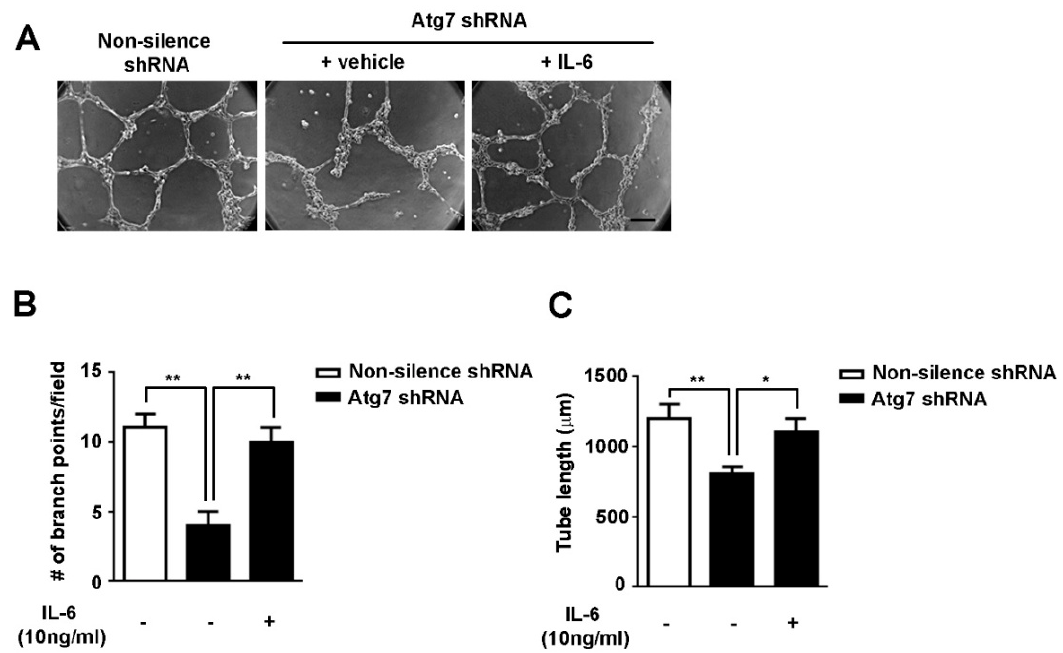
Figure 4. Exogenous addition of IL-6 restored the impaired angiogenesis in brain endothelial cells with Atg7 knockdown. ( A ) Tube formation assays were performed with the indicated HBMEC in the absence (vehicle) or presence of IL-6 (10 ng/mL). The representative images from three independent experiments were presented. Scale, 200 µ m; ( B , C ) To quantify the results in ( A ), the number of branch points ( B ) and the tube lengths were calculated ( C ). * p < 0.05, ** p < 0.01.